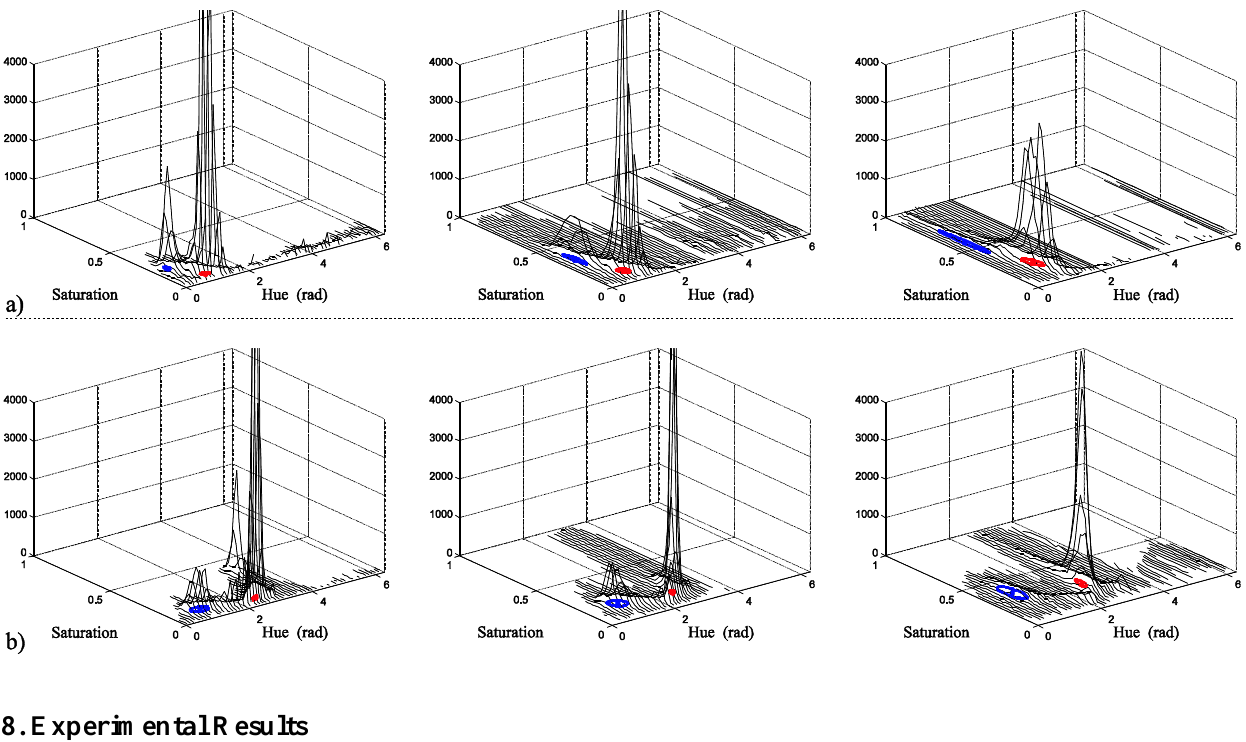
Figure 14. Three 2D Histograms for three intensity mean values for each image, I and I I = 0.70, I = 0.45 and I = 0.21. (a) histograms of the image I, (b) histograms of the m 1 m 2 m 3 image I . We can observe how the distribution statistics of both classes of the image I i less affected by the illumination changes than the ones of image